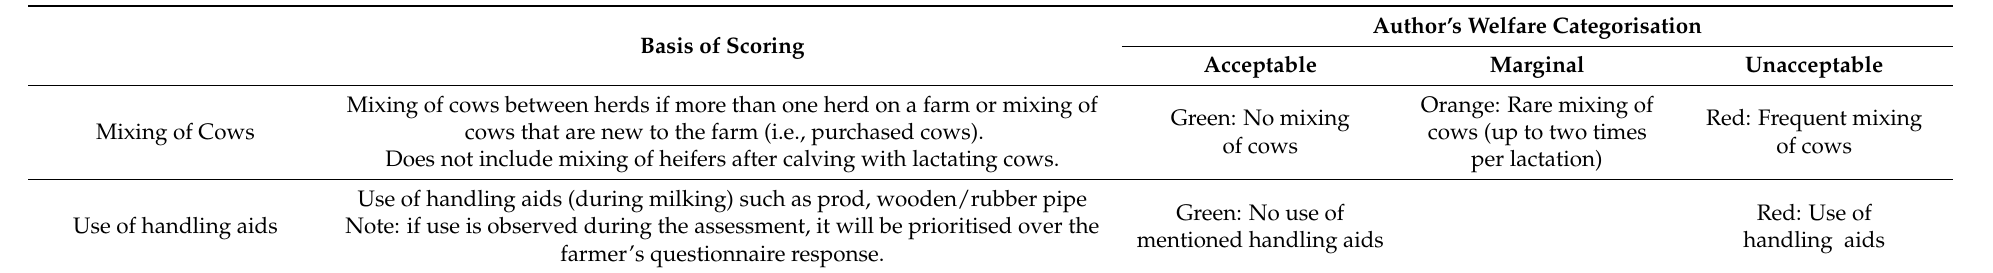
Table 4. Method of assessment for stockpersonship measures obtained from questionnaire, with the categorization based on author-determined threshold. Basis of